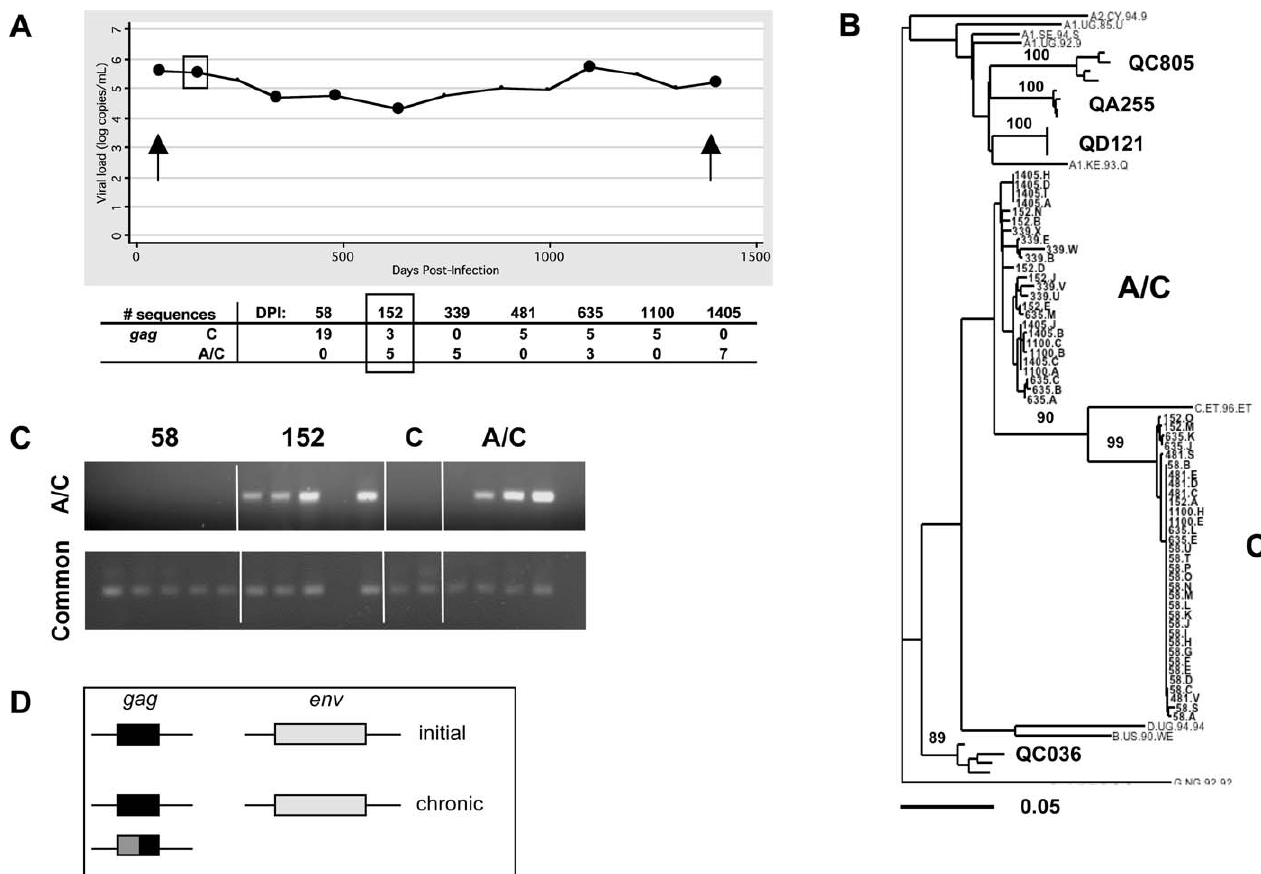
Figure 9. Case 7 (QC885): Intersubtype Superinfection (Subtype C–A) between 58 and 152 DPI Detected in gag (B) Maximum-likelihood tree of gag sequences from all time points. The cluster of strain C contains sequences from all time points except 339 and 1,405 DPI. The cluster of strain A/C contains sequences from 152, 339, 635, and 1,405 DPI. (C) Amplification of 50 gag HIV-1 genome copies from the indicated time points using strain-specific primers (top panel) and common primers (bottom panel). (D) Summary of the strains detected. Light gray ¼ subtype A; black ¼ subtype C.